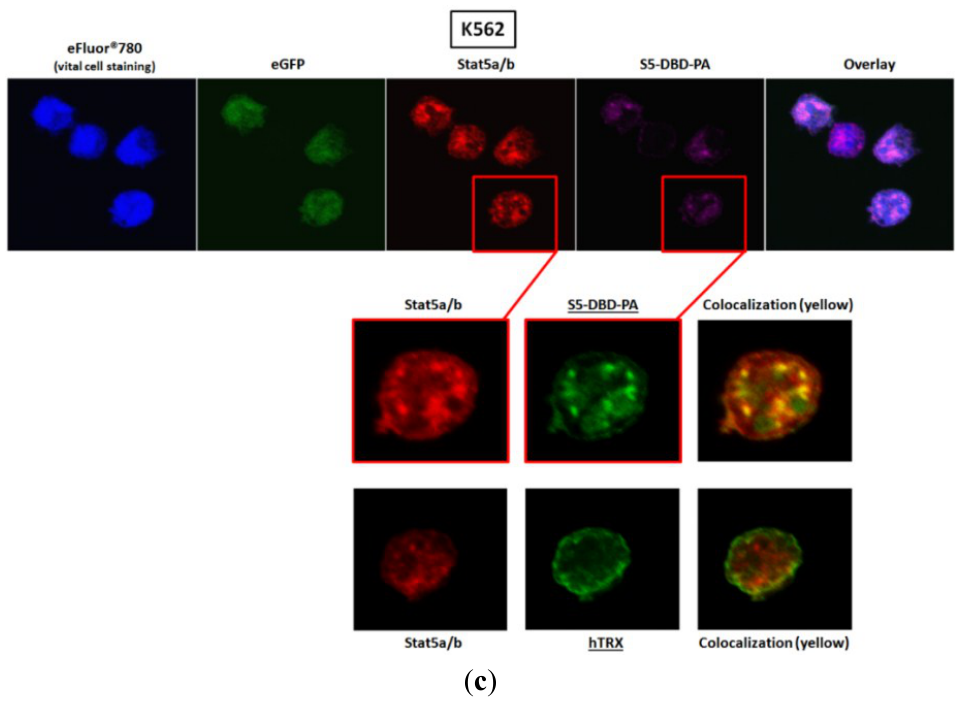
Figure 4. S5-DBD-PA specifically interacts with Stat5 and intracellularly colocalizes with Stat5. ( a ) Co-immunoprecipitation (Co-IP) of recombinant S5-DBD-PA and Stat5. Co-IP studies were carried out either with a mixture of recombinant S5-DBD-PA (f.c.: 1 µM) and recombinant human Stat5a protein (f.c.: 300 nM), incubated for 2 h at room temperature (RT), or with